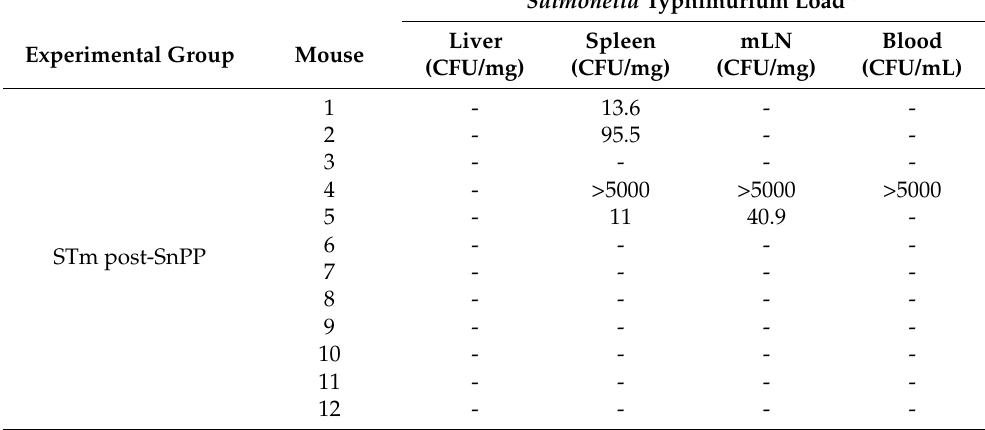
Salmonella Typhimurium Load